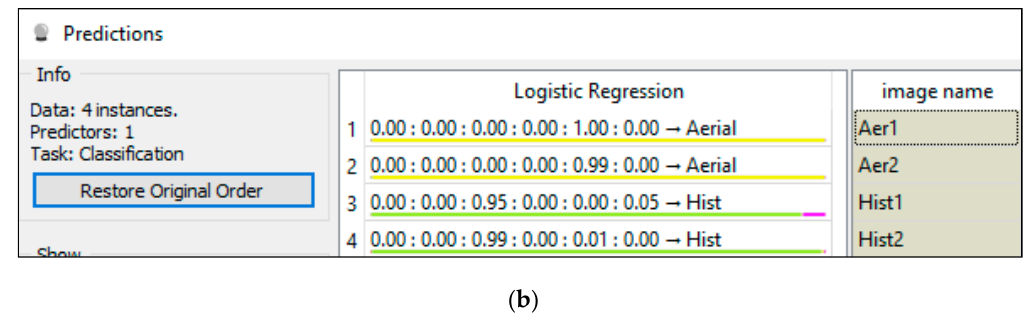
Figure 7. Map category prediction: (a) workflow for predicting map category using the Logistic Regression and Prediction widgets; (b) output table of predictions with probabilities for four maps.